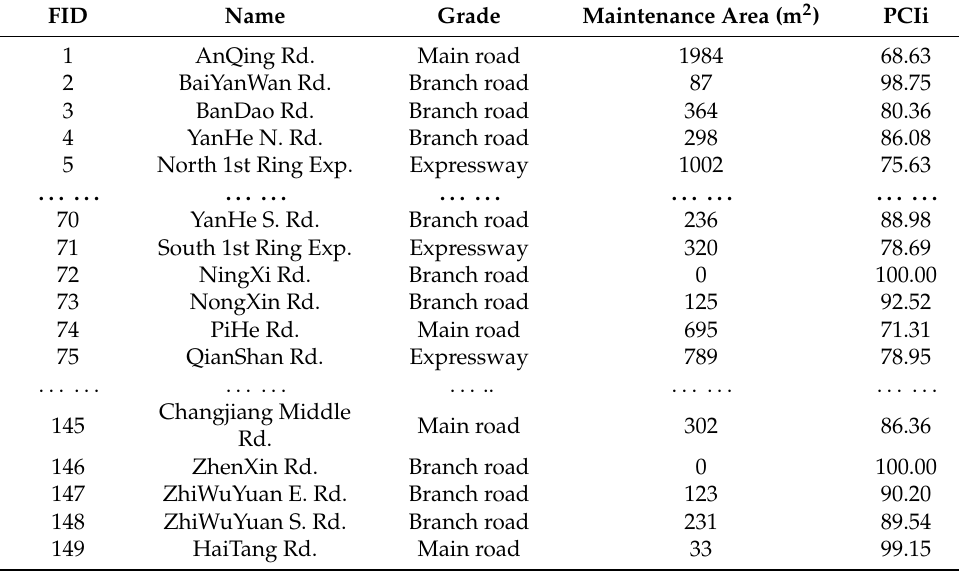
Table 3. PCI and other attributes of roads in Shushan